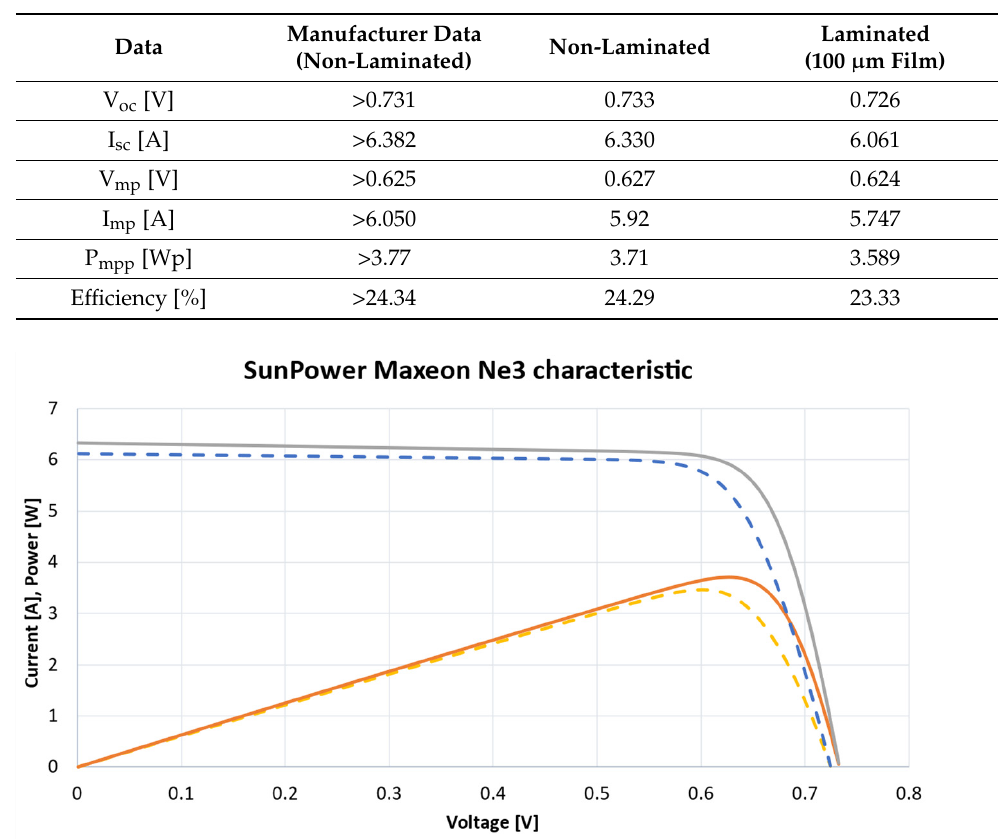
Table 4. Electrical specification of tested solar cells.